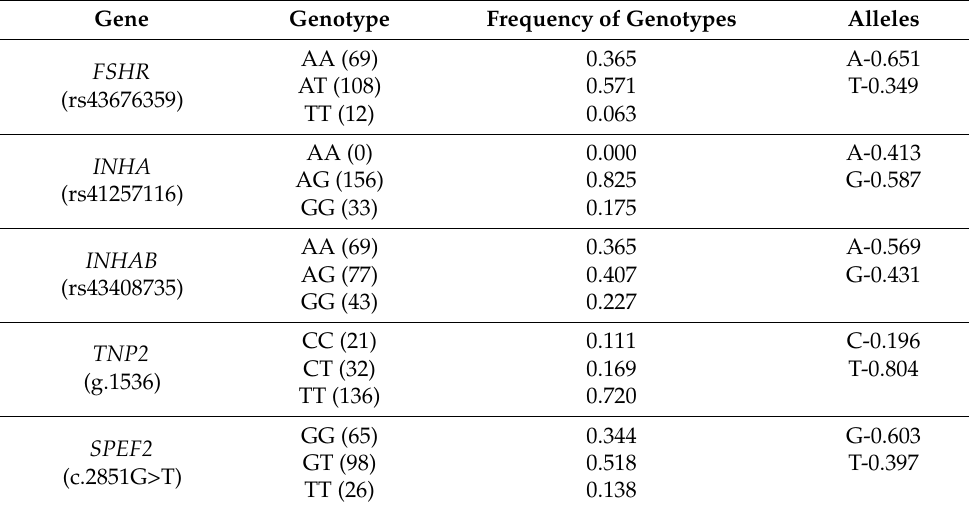
Table 2. Frequency of genotypes and alleles of FSHR , INHA , INHAB, TNP2 and SPEF2 genes in Russian Holstein bulls.